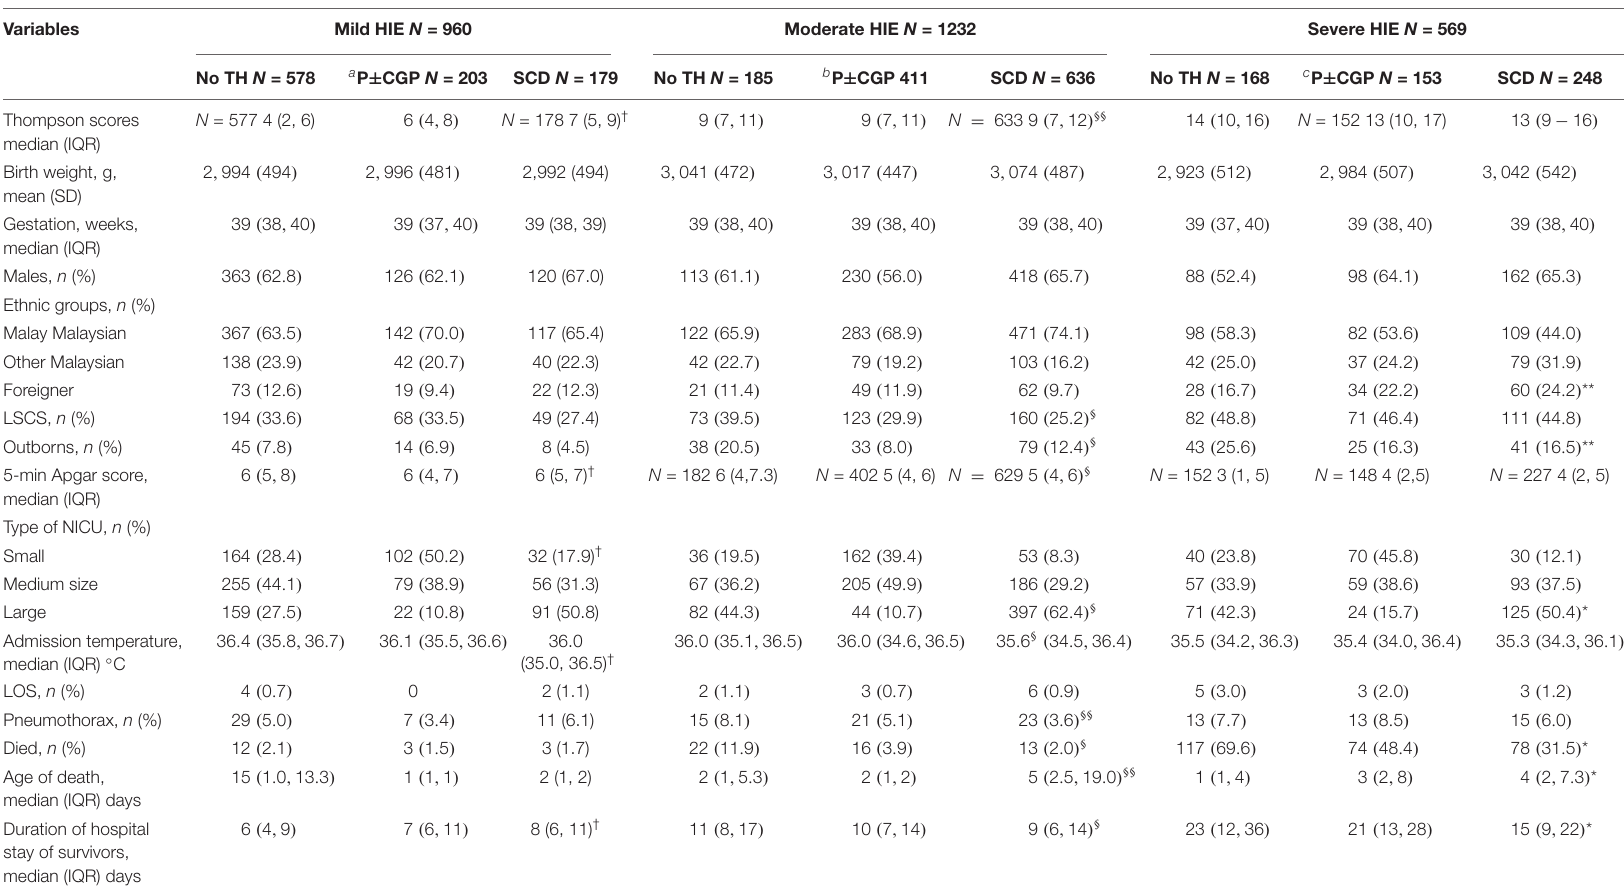
TABLE 3 | Comparison of demographic, clinical and outcome characteristics of neonates with mild, moderate, and severe HIE (based on Sarnat Criteria) treated with different types of therapeutic hypothermia.